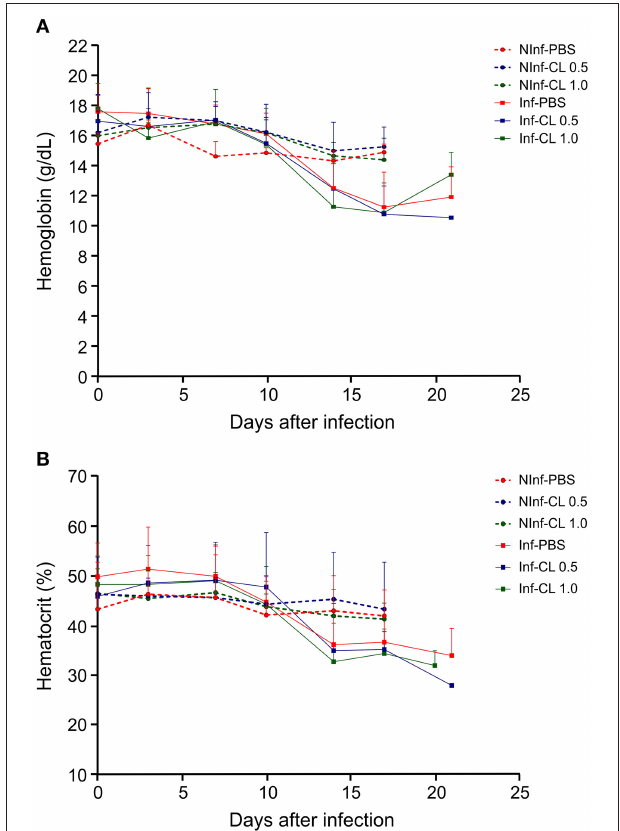
FIGURE 4 | Hemoglobin concentration in the blood (A) and hematocrit (B) of S. sciureus . NInf, non-infected control groups; Inf, P . falciparum -infected groups. Solid lines represent the mean and standard deviation.